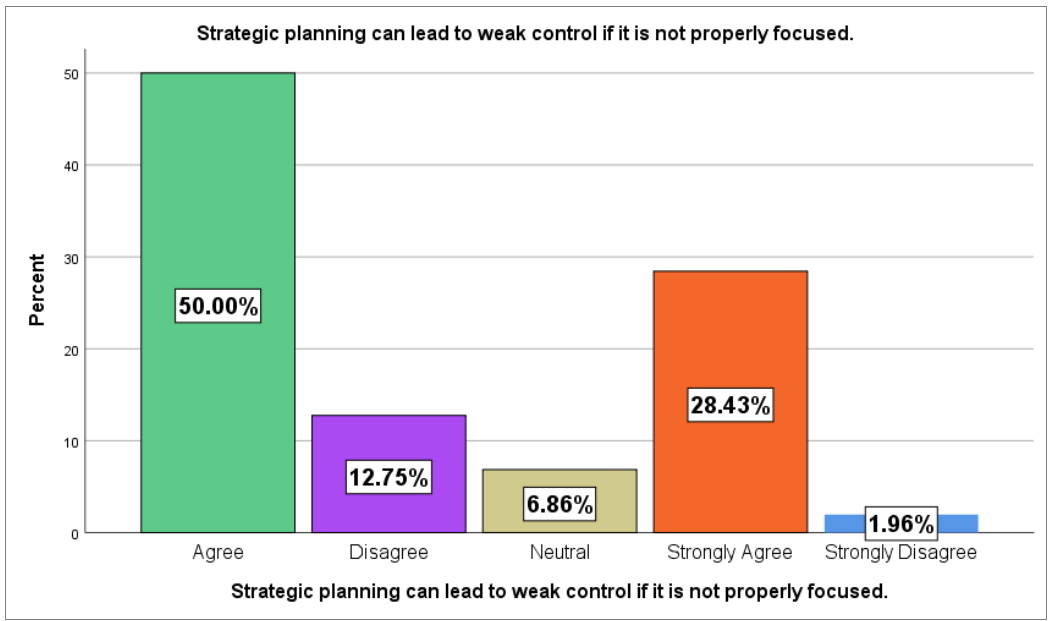
Figure 7. Strategic planning can lead to weak control if it is not properly